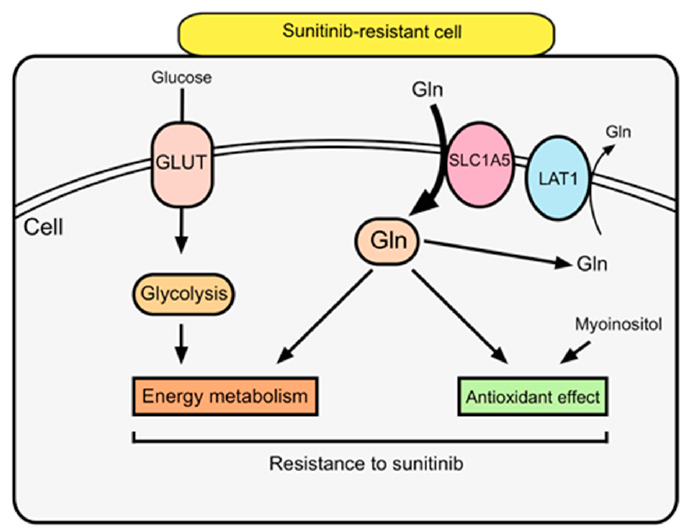
Figure 7. Metabolomic approach reveals mechanism of sunitinib resistance in RCC. In sunitinib- resistant cells, glutamine uptake into the cell through SLC1A5 contributes to both energy metabolism with increasing glutamine uptake and antioxidant effects related to sunitinib